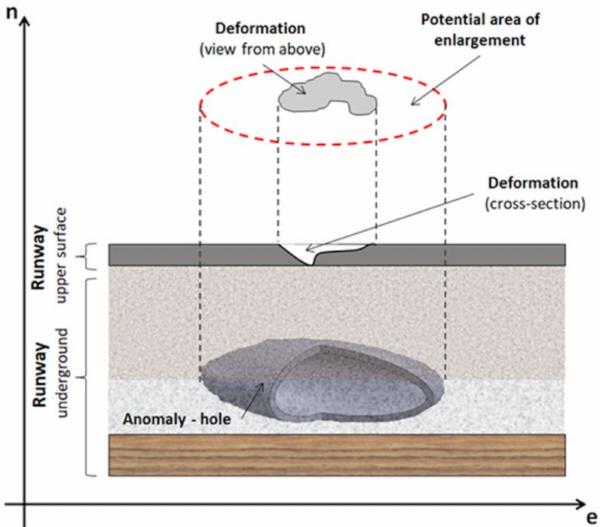
Figure 18. Schematic display of locational connection of the vertical deviation areas on the surface which are detected with geodetic measurements and anomalies in the lower structure detected with the FWD